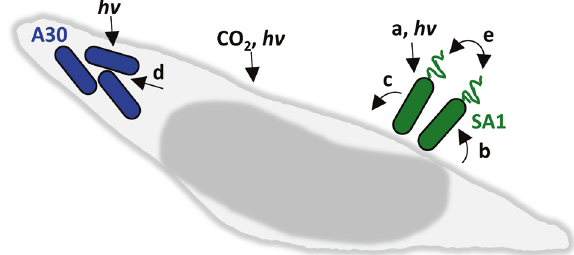
Fig. 6 Model summarizing experimental and bioinformatics fi ndings for bacterial-diatom interactions. Diagram shows a single P. subcurvata cell with associated Olleya sp. A30 (blue) and Sul fi tobacter sp. SA1 (green). Abbreviations: a iron and other inorganic nutrients; b organic carbon, DMSP polypohosphate; c vitamins, detoxi fi cation (ex. catalase), iron, protection; d organic carbon, polyphosphate, iron; e HSL-mediated quorum